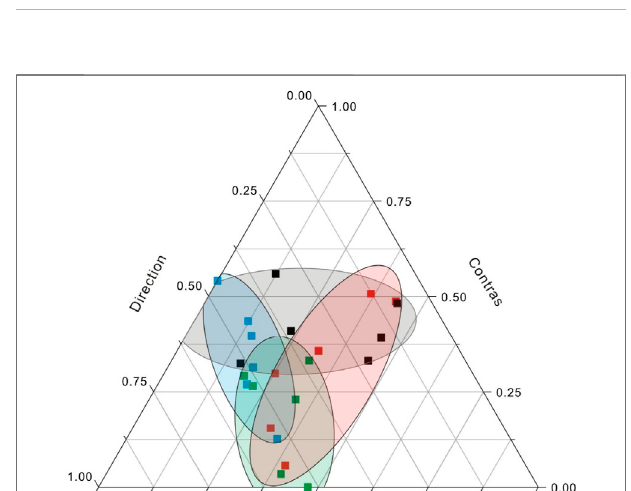
FIGURE 9 | Ternary graph of roughness, contrast and directivity.